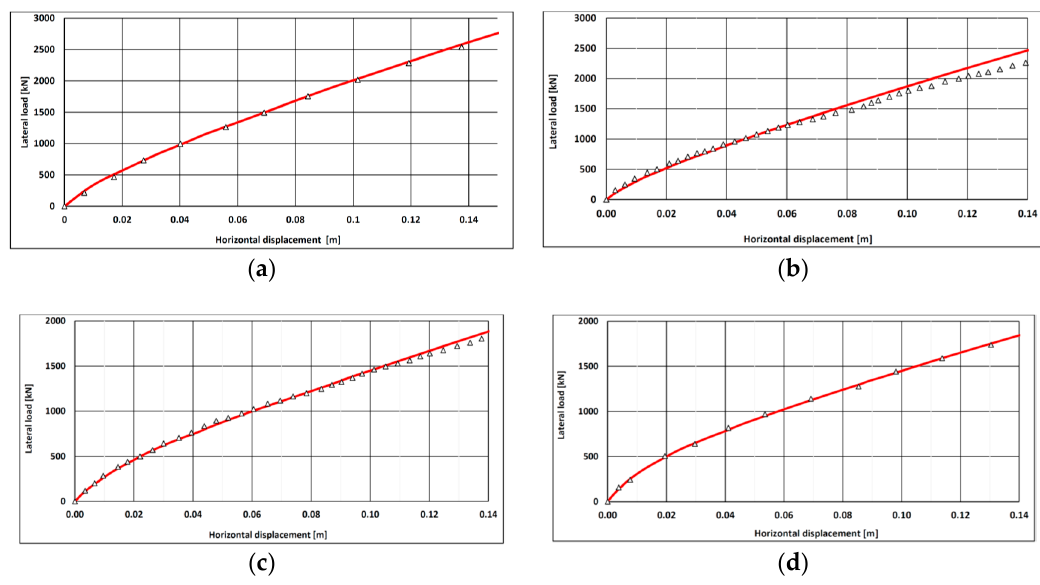
Figure 8. Measured (triangles) vs. computed (red line) load-displacement response for ( a ) single pile; ( b ) pile row—front pile; ( c ) pile row—middle pile; ( d ) pile row—rear pile. Horizontal (lateral) displacements are given in prototype scale.